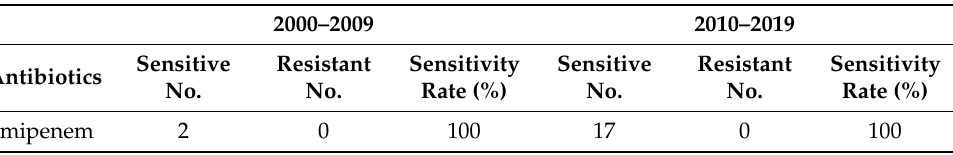
Table 5. Efficacy of antibiotics against the commonly isolated pathogens, MSSA, MRSA, and